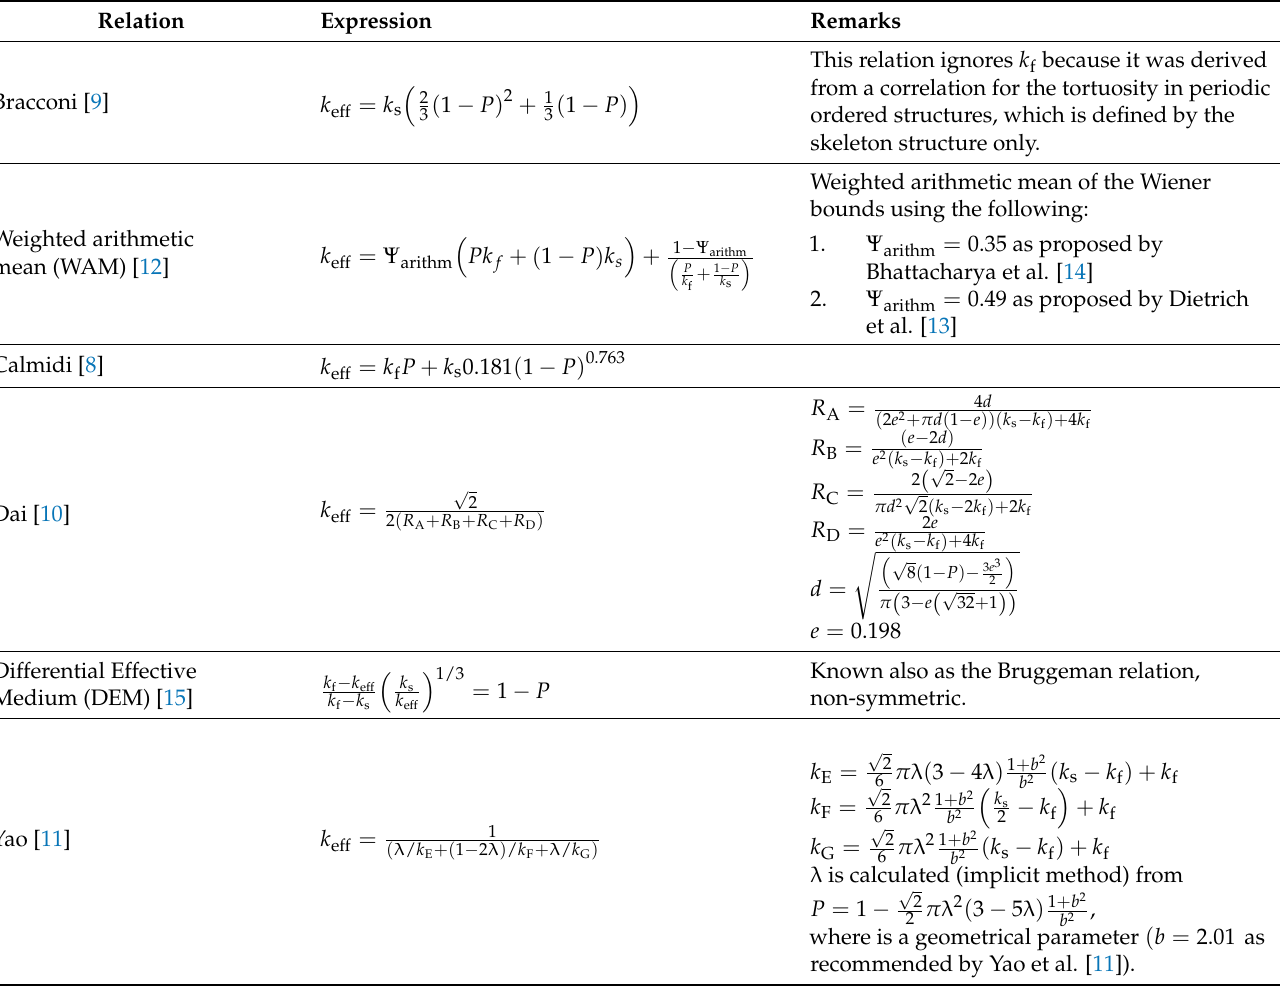
Table 1. Mixing relations applied for estimating the effective thermal conductivity of open-cell